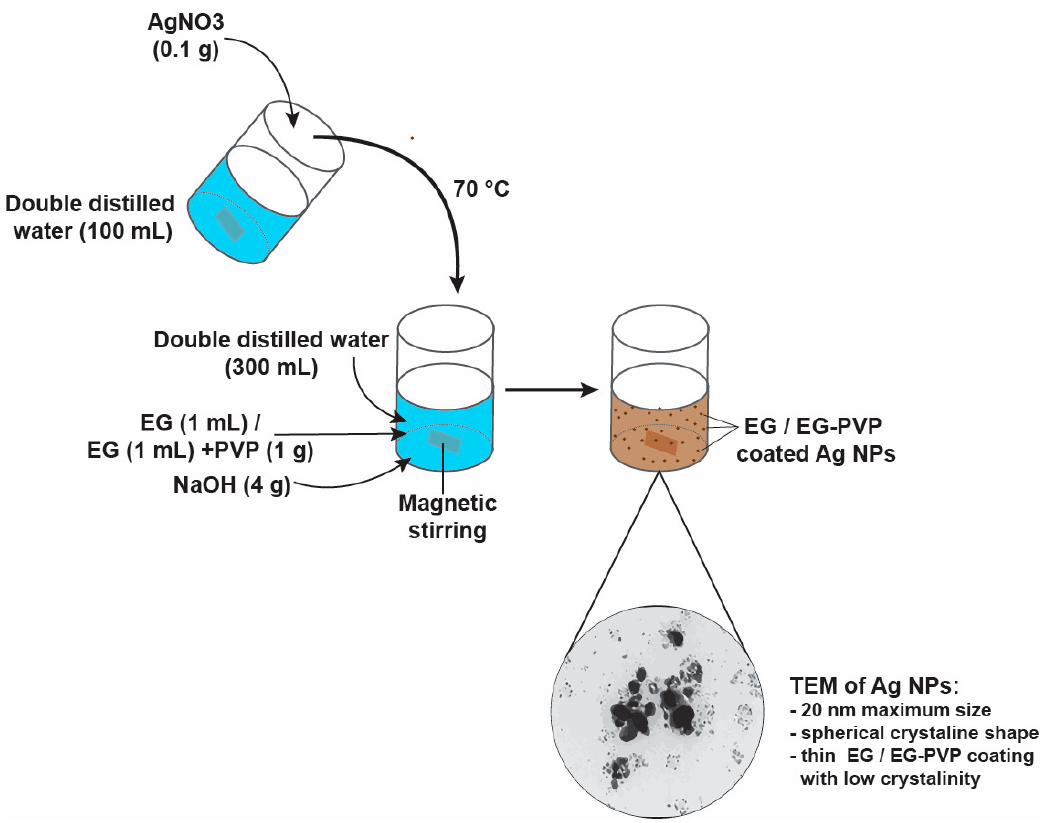
Figure 3. Representation of EG-Ag-NPs synthesis.